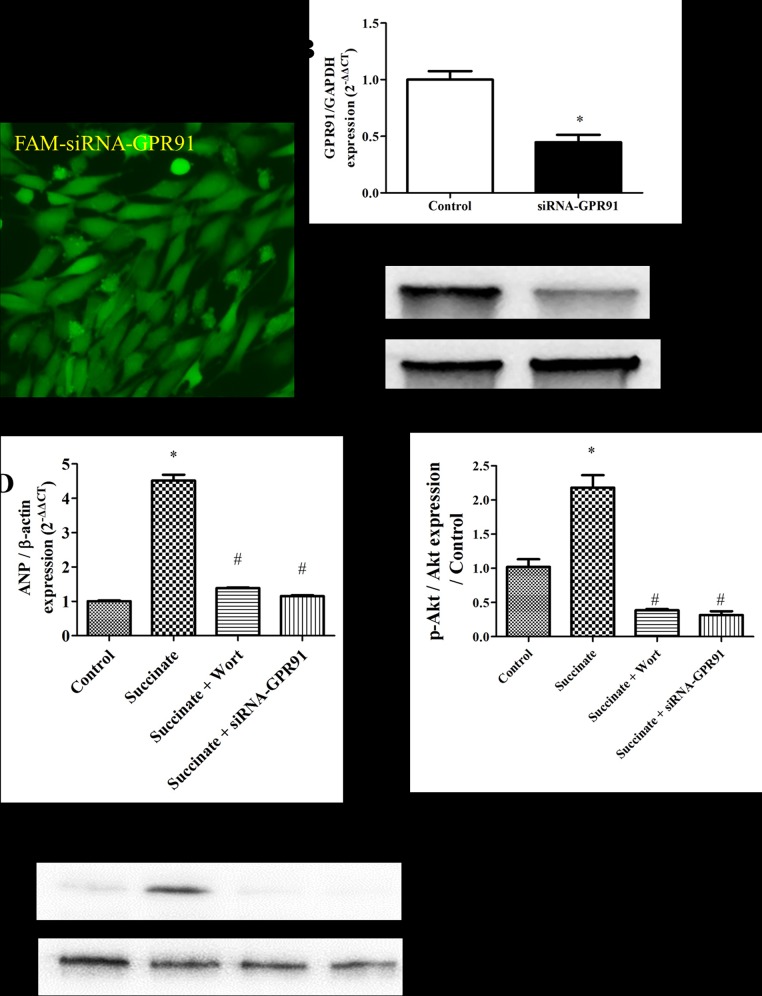
ANP gene expression and PI3K/Akt signaling in cardiac muscle cells in vitro.A: Immunofluorescent images of cardiomyocytes with fluorescein isothiocyanate (FITC)-conjugated siRNA GPR91. B, C: GPR91 gene and protein expression in the sham and siRNA-GPR91 groups (n = 3). D: ANP expression in the sham, succinate, succinate+wortmannin, and succinate+siRNA-GPR91 groups (n = 3). E: Bar graph showng p-Akt/Akt expression as determined by western blot analysis of each group (n = 3). F: p-Akt/Akt expression as determined by western blot analysis of each group (n = 3); *P<0.05 compared to the sham group; #P<0.05 compared to the succinate group.